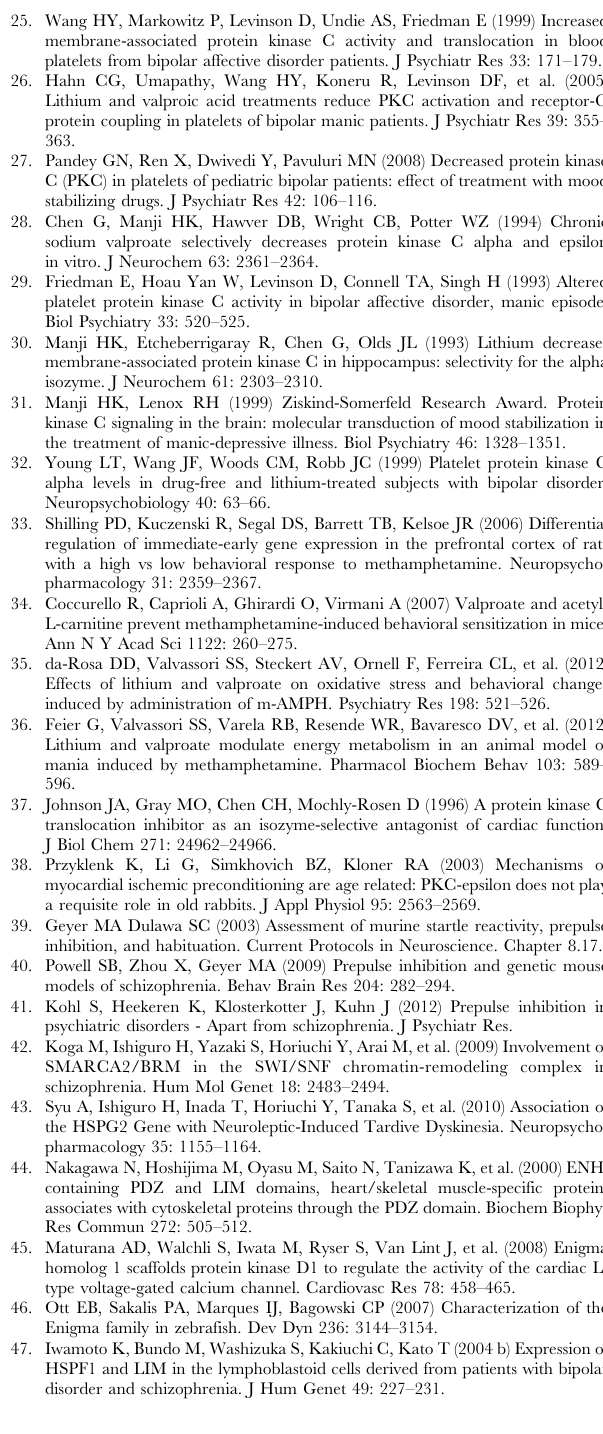
Figure S1 Behavioral characteristics in Pdlim5 hetero knockout mice. The rota-rod, novelty-seeking, social interac- tion, locomotion, and prepulse inhibition tests were conducted in Pdlim5 + / + and Pdlim5 + / 2 mice. These behaviors showed no significant differences between the 2 genotype groups. Values are shown as mean 6